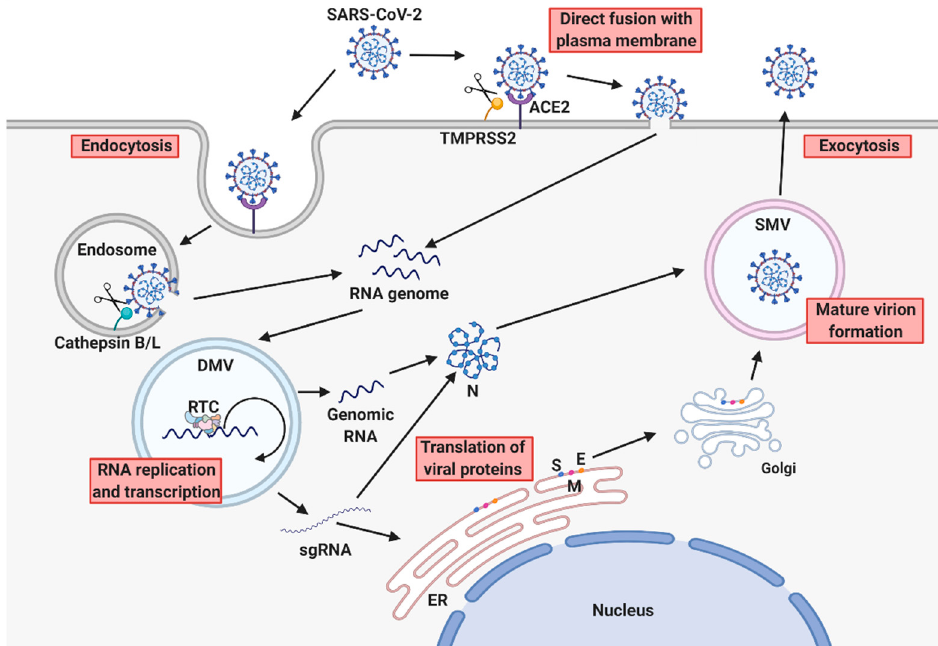
Figure 1. SARS-CoV-2 replication cycle. Viral entry of SARS-CoV-2 is initiated by the recognition of the host cell receptor ACE2 via the RBD of the S glycoprotein. After binding to host cell receptors, SARS-CoV-2 enters cells by endocytosis or direct fusion with the plasma membrane. The host proteases TMPRSS2 and cathepsins B and L mediate the proteolytic cleavage of the S protein, triggering membrane fusion and viral genome release into the cytoplasm. The RTC carries out viral RNA synthesis in DMVs, and newly produced viral RNAs and proteins are delivered to SMVs for assembly of new viruses. Finally, virions are secreted by exocytosis. This figure was created by BioRender.com accessed on 10 September 2021 (BioRender, Toronto, ON, Canada).